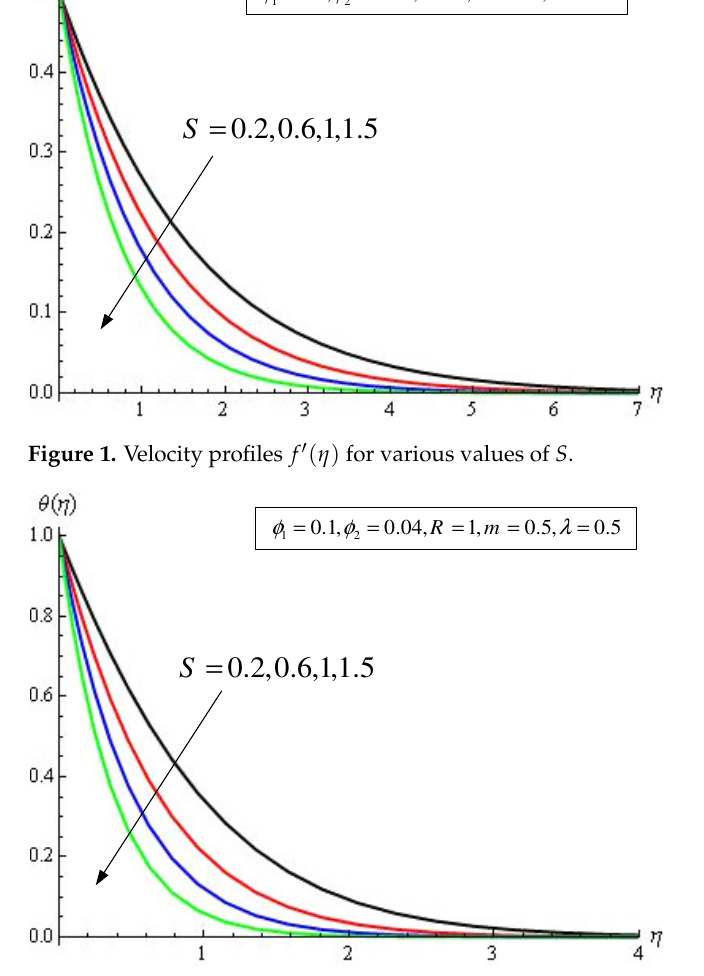
Figure 2. Temperature distributions of the hybrid nanofluid for various values of S .